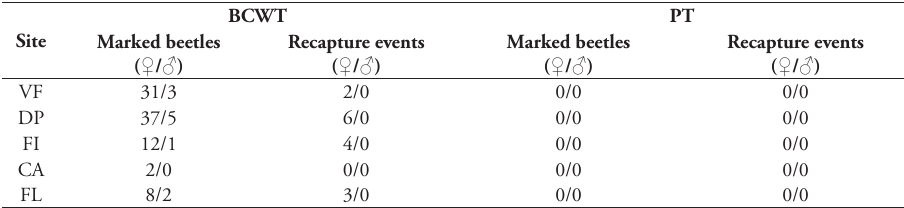
Table 6. Occupancy and detection probability estimates by monitoring during 2015. O.eremita occu- pancy ( ψ ) and detection ( p ) probability estimates and associated standard errors (in parenthesis), are given for plausible candidate models (within 2 ΔAIC of the top model). The data were obtained by monitoring during 2015 in the two macroareas PA and FC (PA= Parco Nazionale d’Abruzzo Lazio e Molise; FC = Foreste Casentinesi; VF = Val Fondillo; DP = Difesa di Pescasseroli; FI = Feudo Intramonti e Colle di Licco; FL = Foresta della Lama).